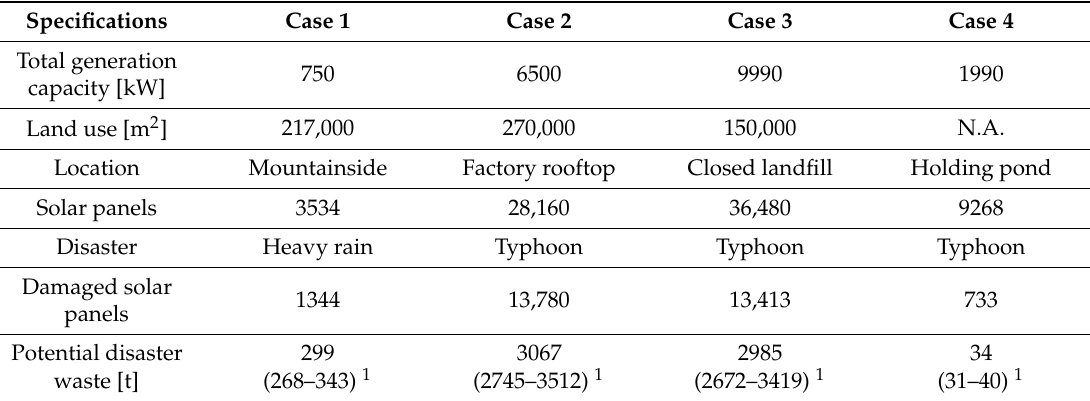
Table 5. Estimated disaster waste derived from PV equipment.